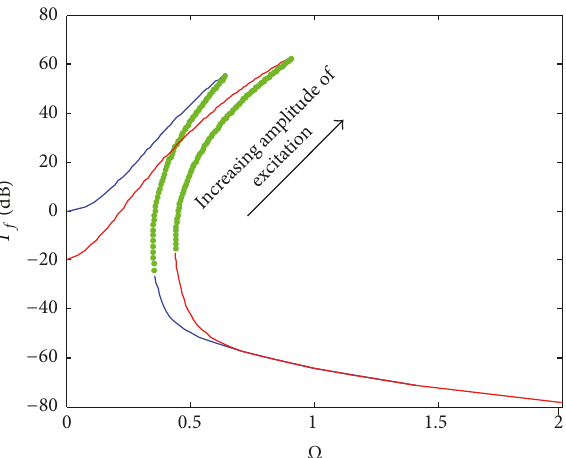
Figure 13: Effect of different excitation amplitudes on the quasi- zero-stiffness force transfer